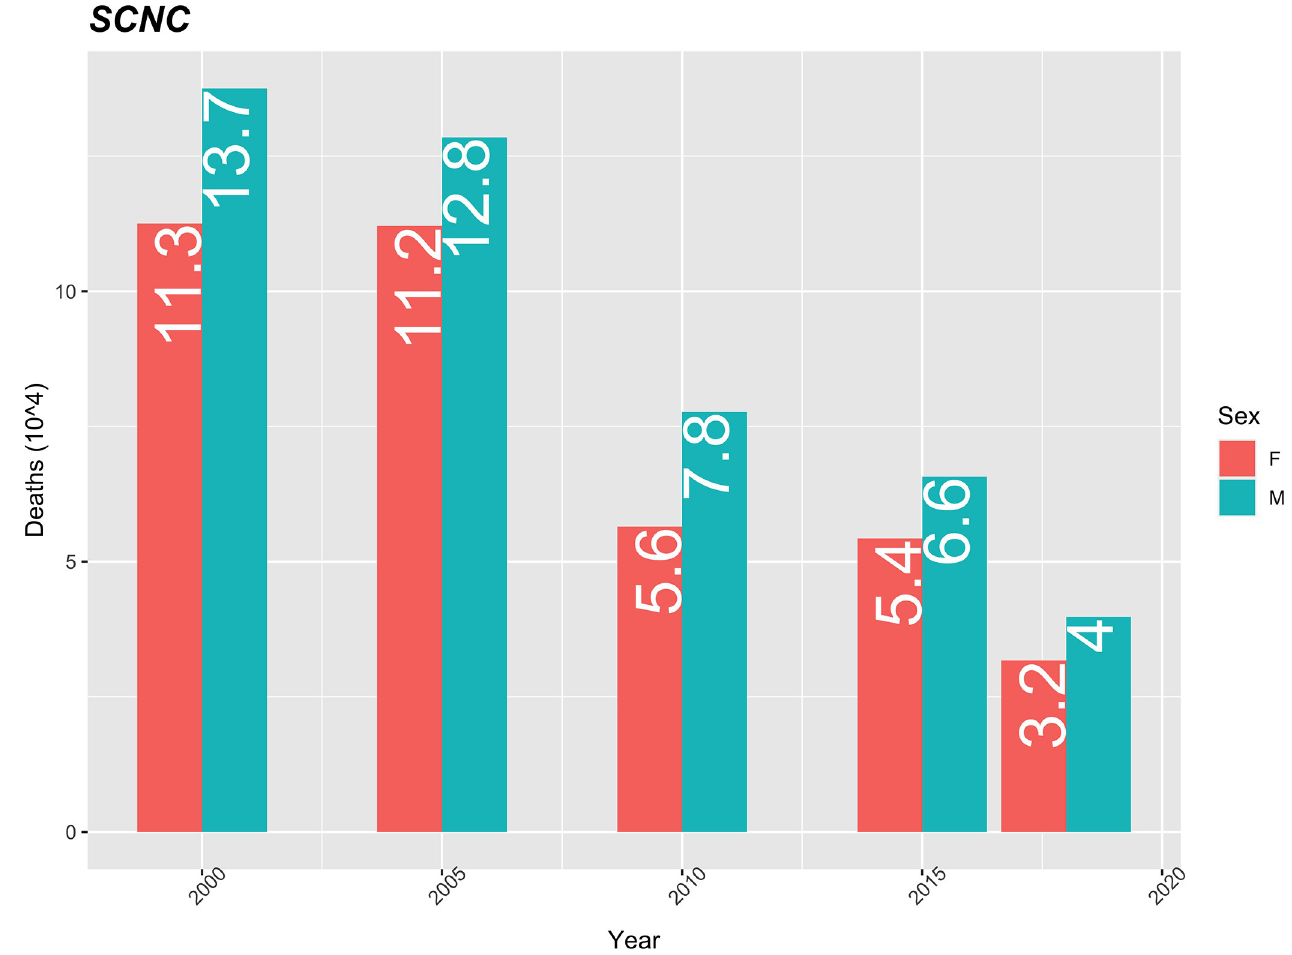
Fig 6. SCNC mortality rate (10 thousand) standardized by age, using the population of Cape Verde in 2010 as the standard.